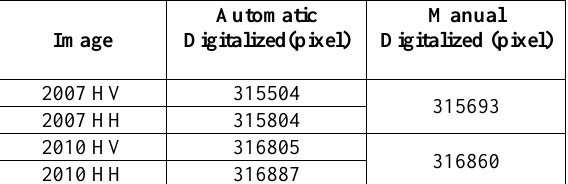
Table 2. Comparison between automatic coastline detection and manual digitizing.